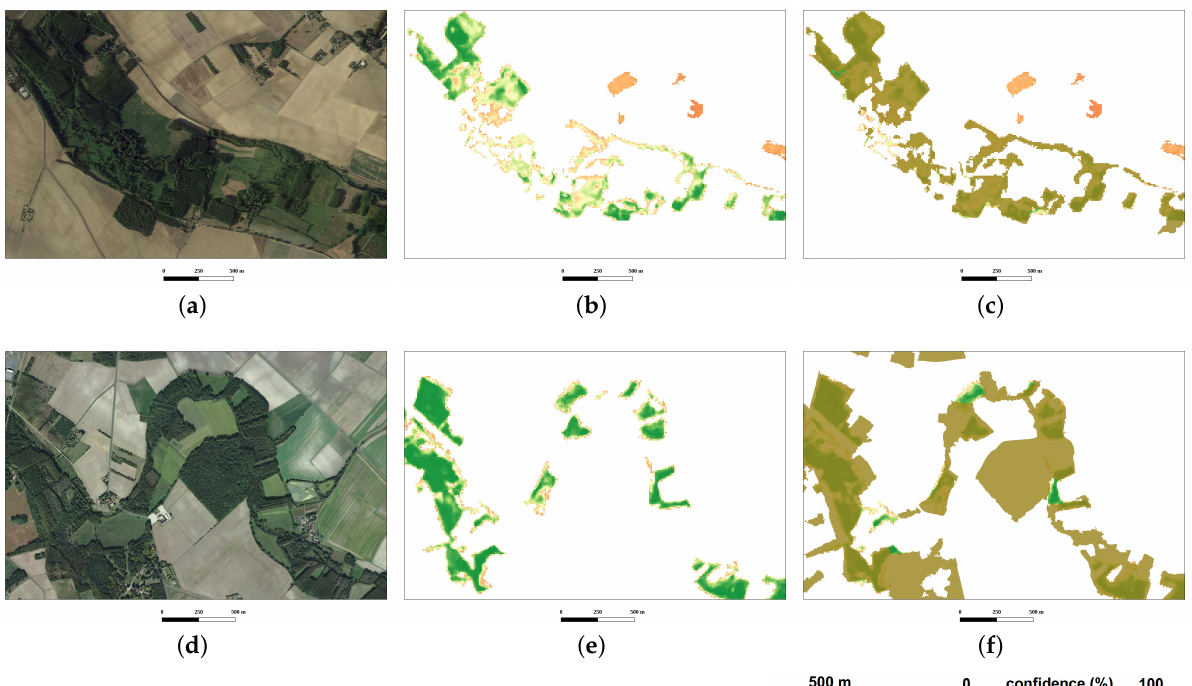
Figure 10. Map extracts located in the Indre department in tile 31TCM: ( a , d ) are the 2018 orthophotos, ( b , e ) are the confidence maps with a red-yellow-green scheme palette for the classified poplars (the highest confidence rates in green), and ( c , f ) show the overlay of the forest mask derived from the national forest database (BDForêt ® IGN,